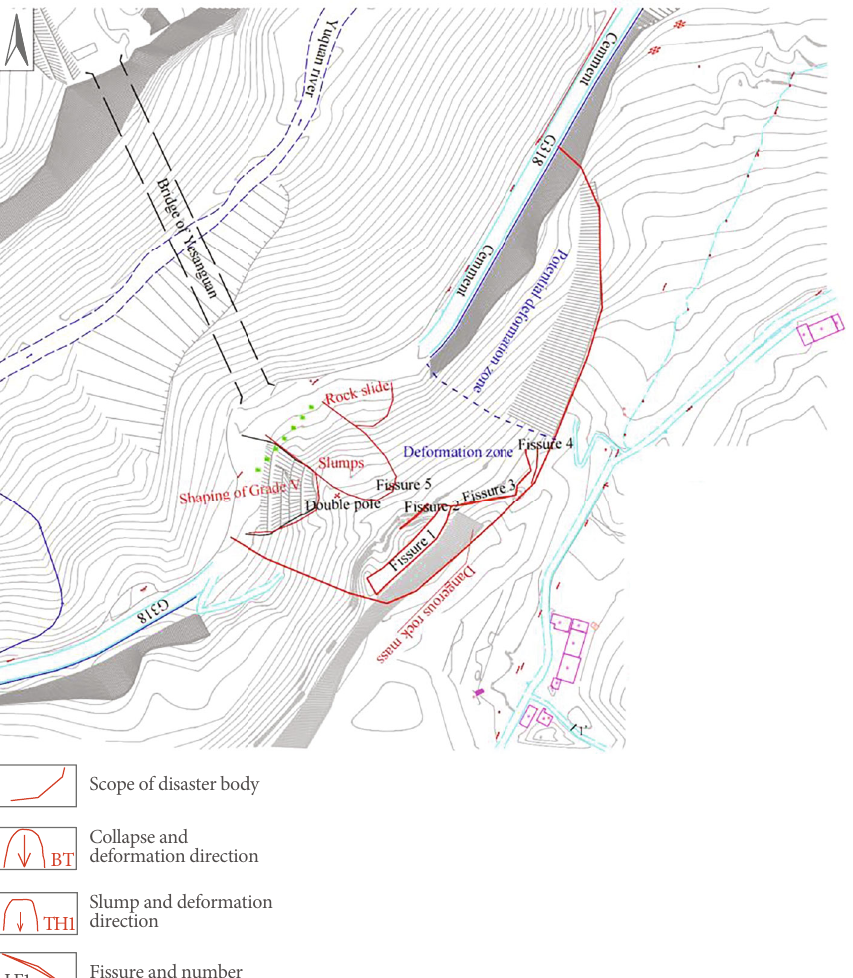
Figure 4: Plan diagram of Tanziyan landslide geological hazard.